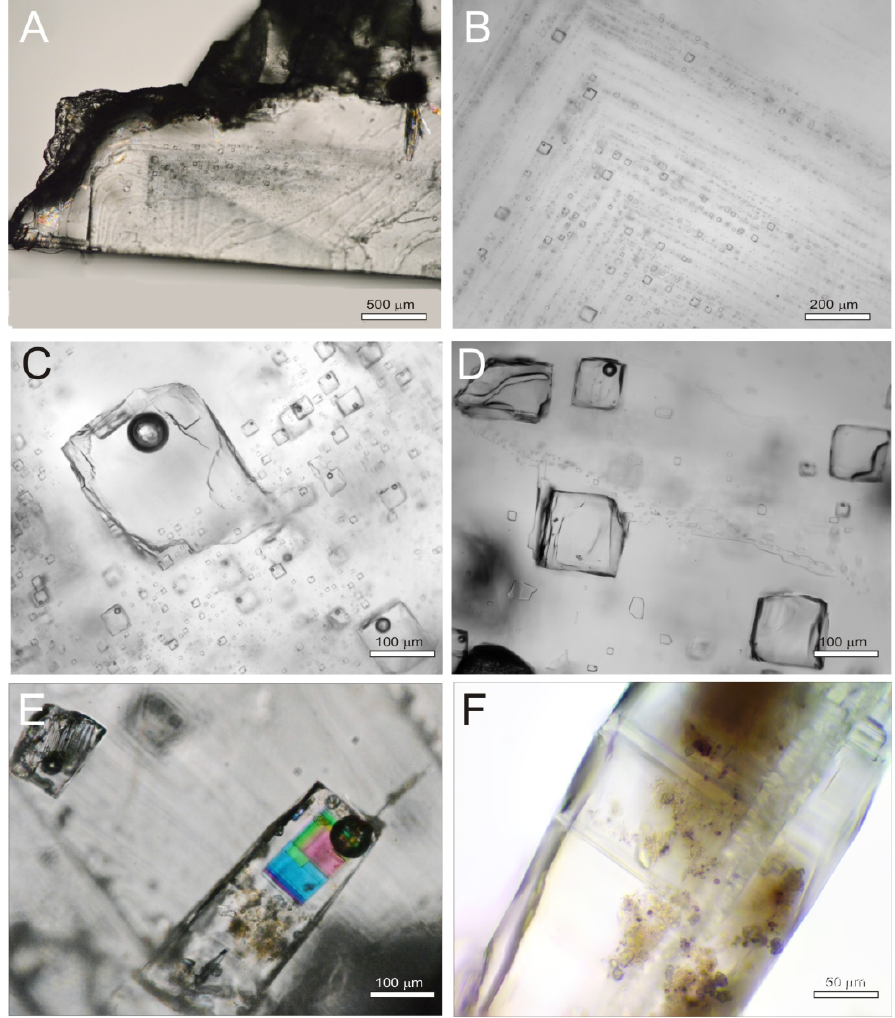
Figure 6. Photomicrographs are showing various types of fluid inclusions in halite from the Huwniki-1 well. ( A ) A fragment of a primary halite crystal, with irregular dissolved surface underlined by sulfates’ presence, sample no. H-III-70. ( B ) Well-preserved primary chevron texture, sample no. H-III-70. ( C ) Two-phase (gas–liquid) inclusions, sample no. H-VI-10. ( D ) Irregular large secondary inclusions in clear halite, sample no. H-IV-0. ( E ) A secondary three-phase (gas–liquid–anhydrite) inclusion; the high-order interference colors displayed by the euhedral crystal of anhydrite, sample no. H-III-70 crossed nicols. ( F ) Light-yellow to brown low-carbon organic substance, within a large secondary fluid inclusion, sample no.